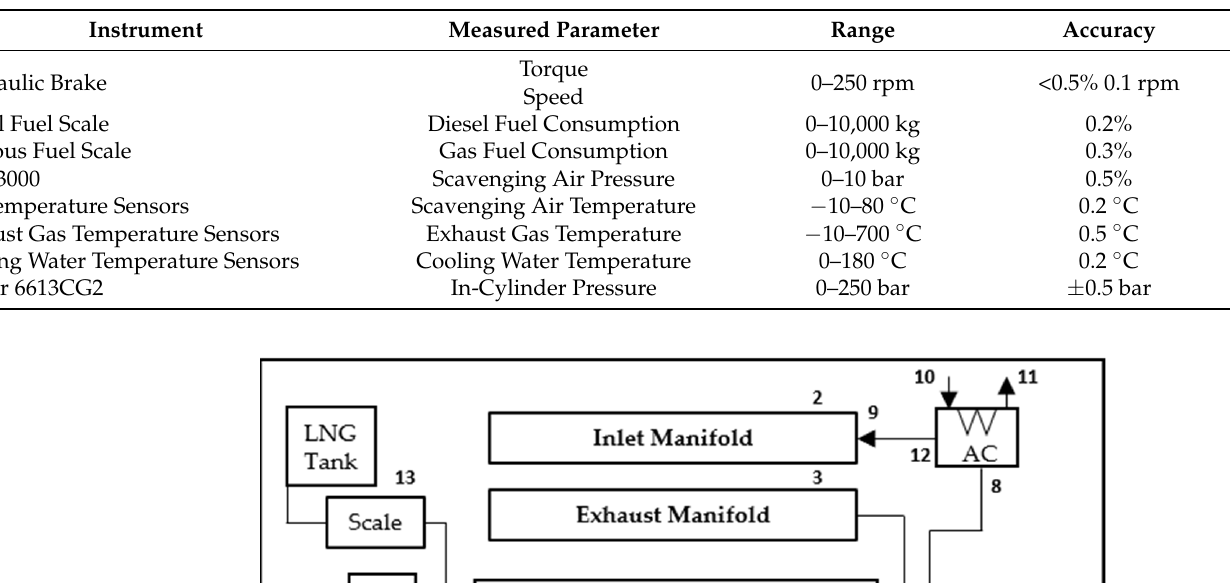
Table 3. Characteristics of instrumentation for engine performance monitoring.